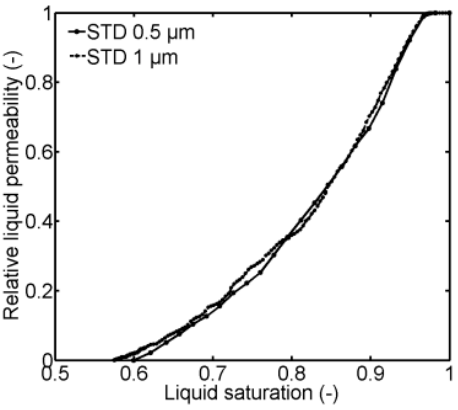
Figure 14. Permeability variation for simulations with low and high standard deviation of PSD.